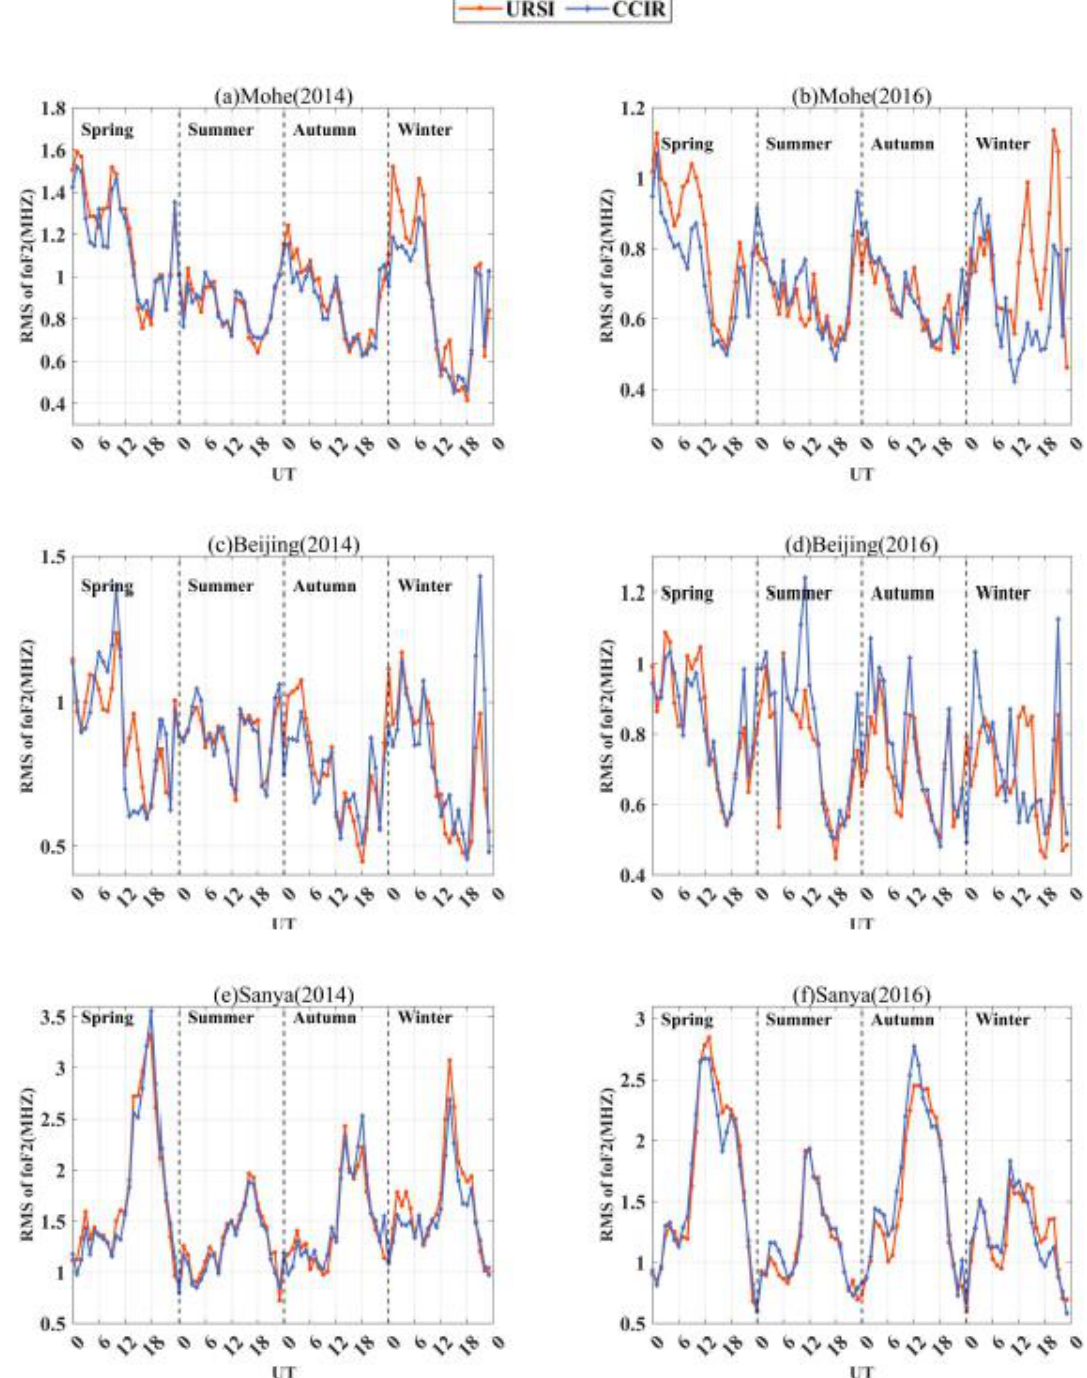
Figure 5. Diurnal RMS variation of IRI-2016 URSI and CCIR predicted foF2 from the ionosonde foF2 in the four different seasons for the years 2014 and 2016 at Mohe, Beijing and Sanya over China. ( a ) Mohe(2014), ( b ) Mohe(2016), ( c ) Beijing(2014), ( d ) Beijing(2016), ( e ) Sanya(2014), ( f ) Sanya(2016).